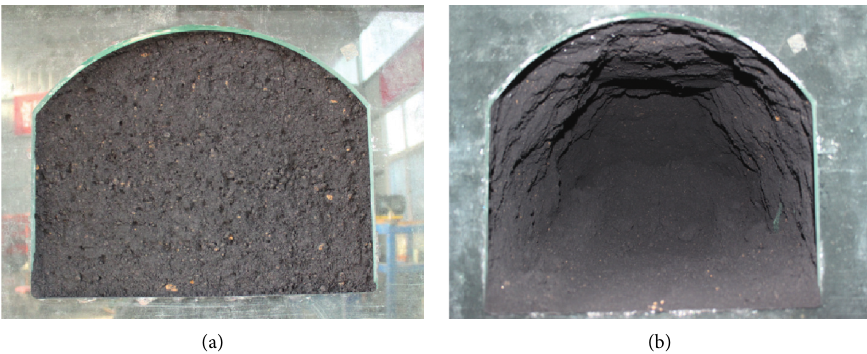
Figure 14: Excavation sequence sketch of the entire section method. (a) Initial excavation face. (b) Entire section